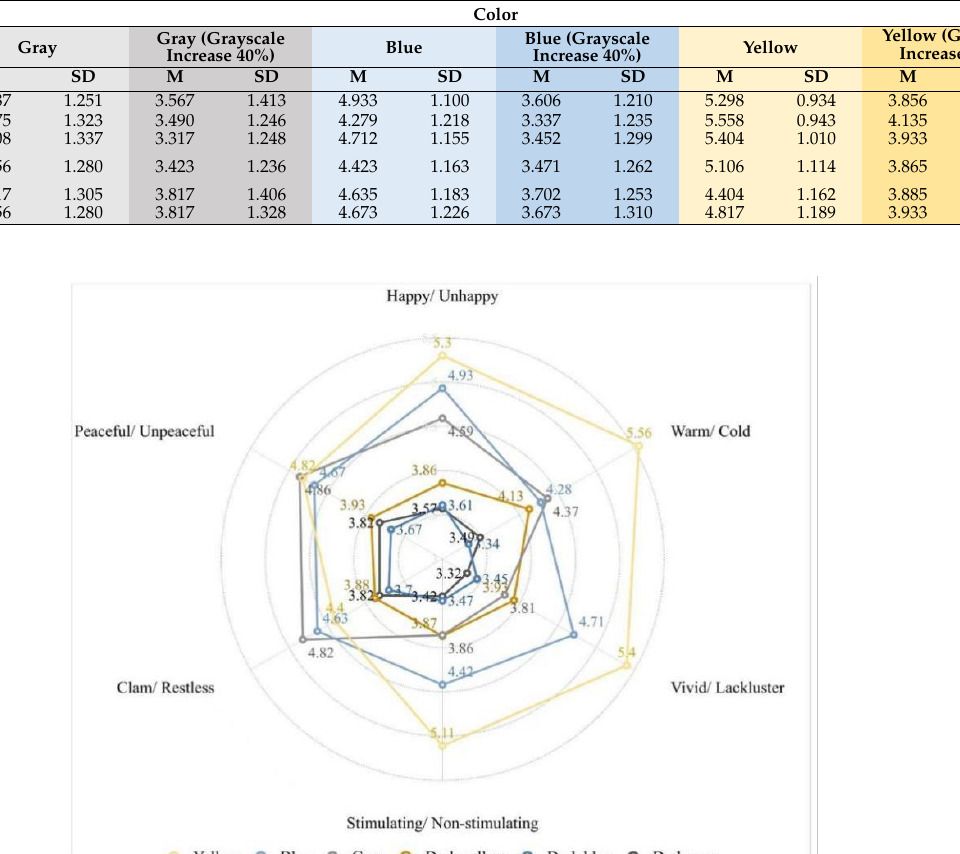
Table 4. Means and standard deviations of participants’ ratings of emotional experience.